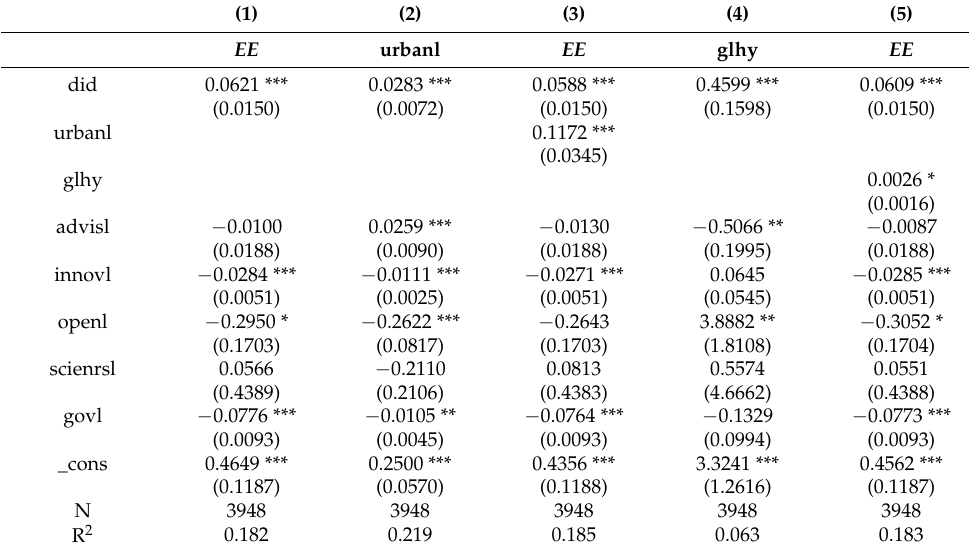
Table 7. Regression results of mechanism